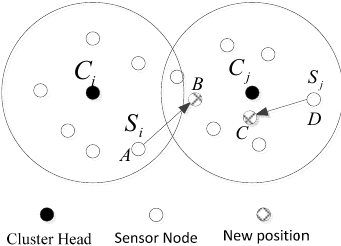
Figure 4. A schematic description of nodes’ mobility in a sensor network.